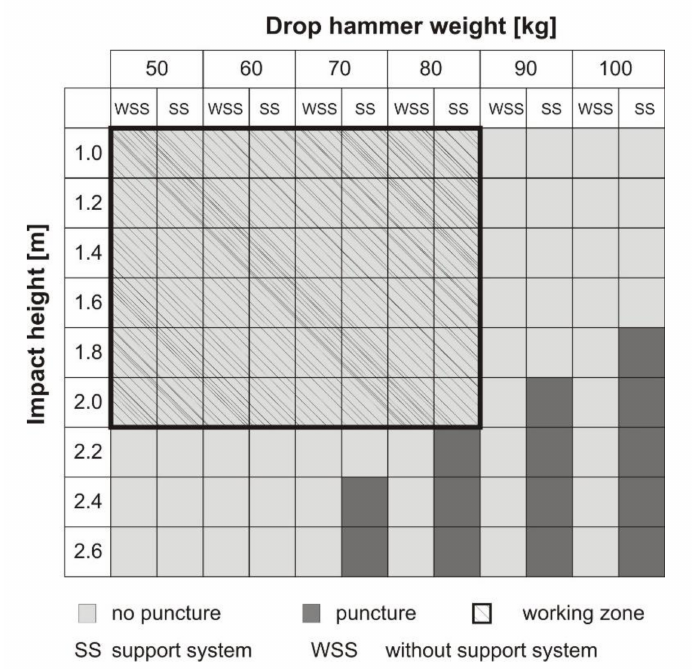
Figure 3. Puncture occurrence.